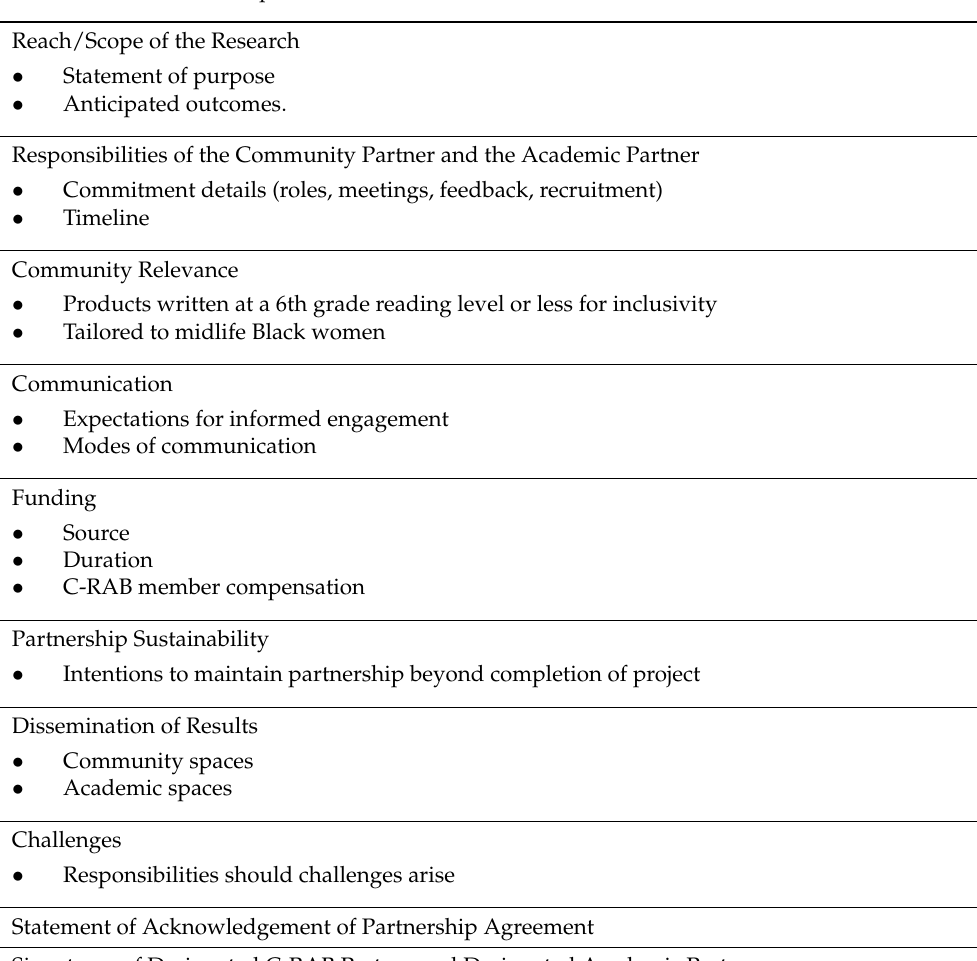
Table 1. C-RAB Partnership